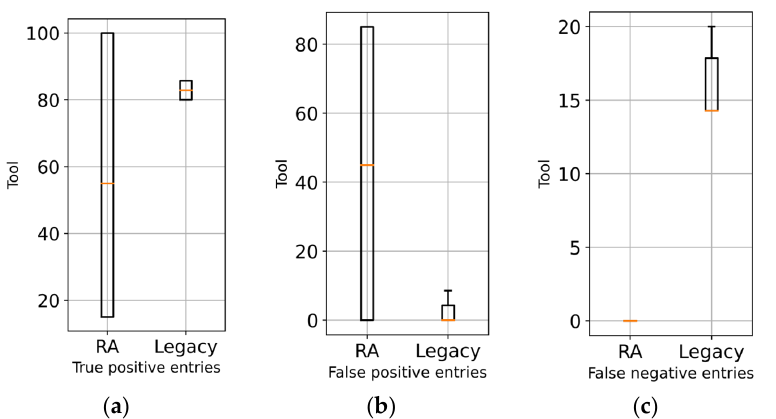
Figure 13. Outcome of the KPIs calculated on the final risk evaluations performed by the users. The RA tool had, on average, a larger percentage of false positive entries ( b ) and a lower percentage of true positive ones ( a ) when compared with the legacy tool. However, the percentage of false negative entries ( c ) was lower in the RA compared to the legacy tool.